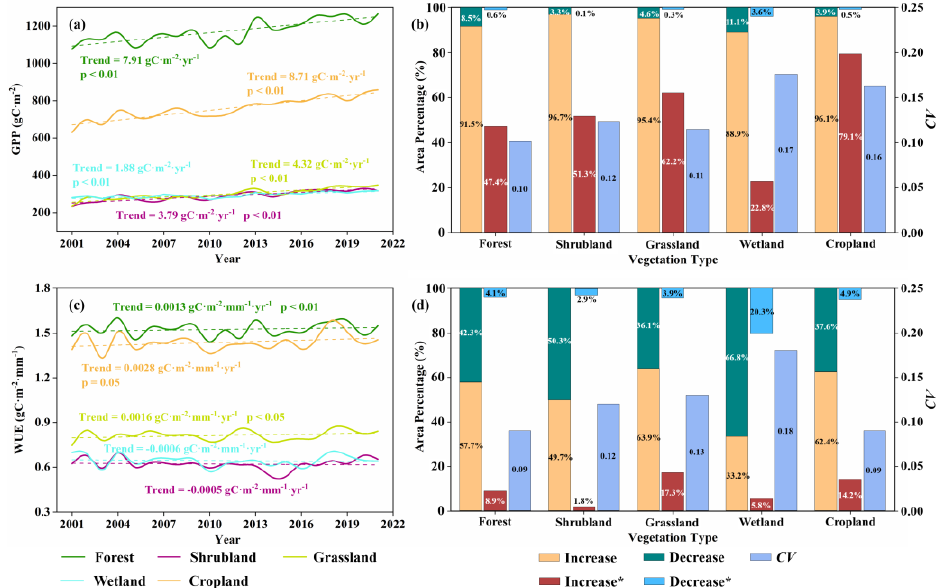
Figure 5. Temporal trends of GPP and WUE for different vegetation types across China from 2001 to 2021. ( a , c ) indicate the trends of annual average GPP (units: gC · m − 2 · yr − 1 ) and WUE (units: figure . ( b , d ) represent the area percentage with increasing or decreasing trends of GPP and WUE in different vegetation types and the average C V values of both. Increased* Decreased*: indicates the change of GPP or WUE reached a significant level ( p < 0.05).